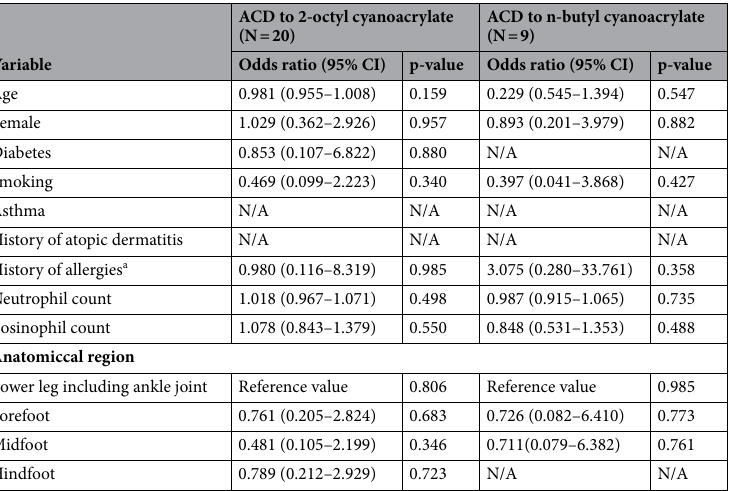
Table 2. Results of logistic regression analysis to assess the risk factors of allergic contact dermatitis to topical skin adhesives. ACD allergic contact dermatitis, CI confidence interval, N/A not applicable. a Antigens other than topical skin